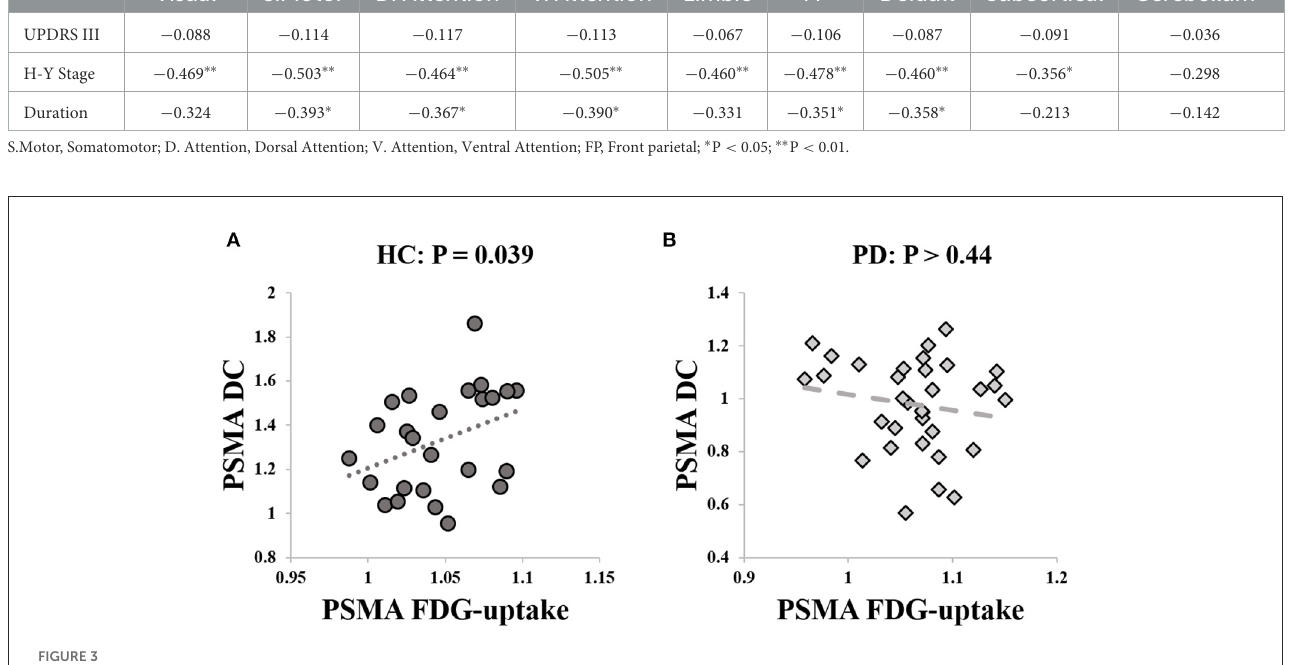
(P uncorrected < 0.001, Supplementary Figure S2). However, there was no spatial overlap between the increased FDG-uptake cluster and the reduced PSMA DC cluster. The SUVr value extracted from the P uncorrected < 0.001 cluster in PSMA did not correlate with PSMA DC in any groups ( P -values > 0.8), nor did it correlate with any clinical measurements ( P -values >